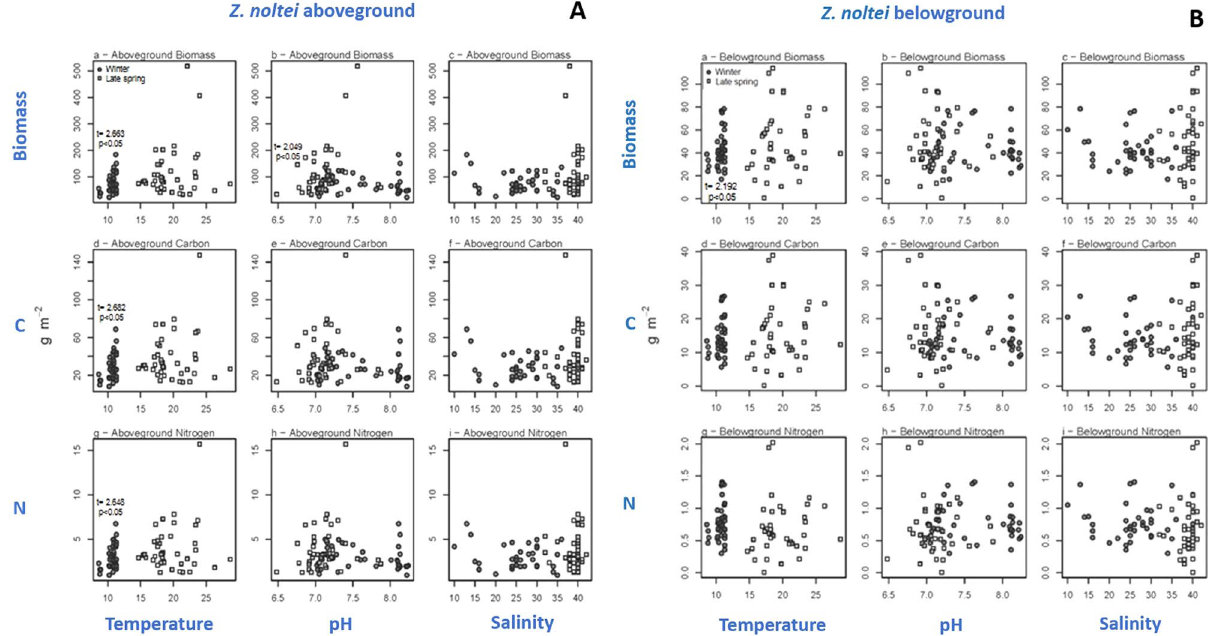
Figure 4. Zostera noltei biomass (gDW m − 2 ) versus ( a ) temperature, ( b ) pH and ( c ) salinity in winter and late spring; C pool (gC m − 2 ) versus ( d ) temperature, ( e ) pH and ( f ) salinity; and aboveground N pool (gN m − 2 ) versus ( g ) temperature, ( h ) pH and ( i ) salinity. Statistical significant linear relationships within each season are shown (t value; p < 0.05). A - refers to Z . noltei aboveground biomass, C and N pools; B - refers to Z . noltei belowground biomass, C and N pools. All statistical results are shown as Supplementary information (Table